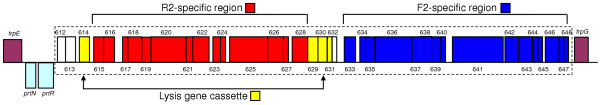
Genetic organization of the R2/F2 pyocin gene locus according to Michel-Briand and Baysse [40] and Nakayama et al. [41]. Each box represents a gene between PA0609 (trpE) and PA0649 (trpG). Genes inside the dotted line were upregulated upon exposure to hydrogen peroxide (see, Table 3).